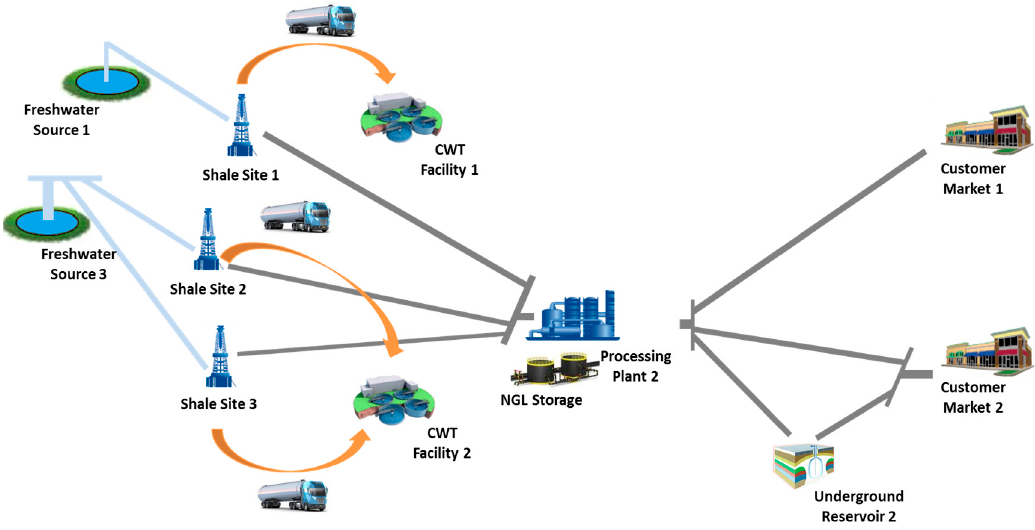
Figure A2. Optimal shale gas supply chain network for deterministic model (base case).